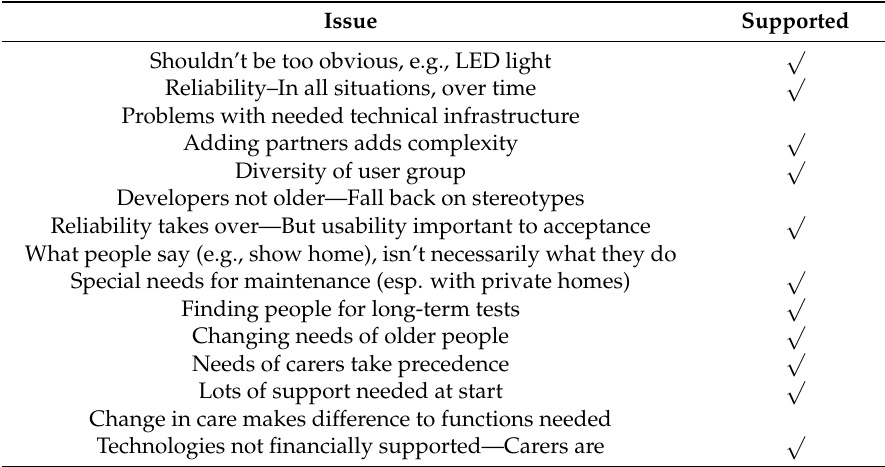
Table A2. Issues given to workshop participants to gain support for them. Issue